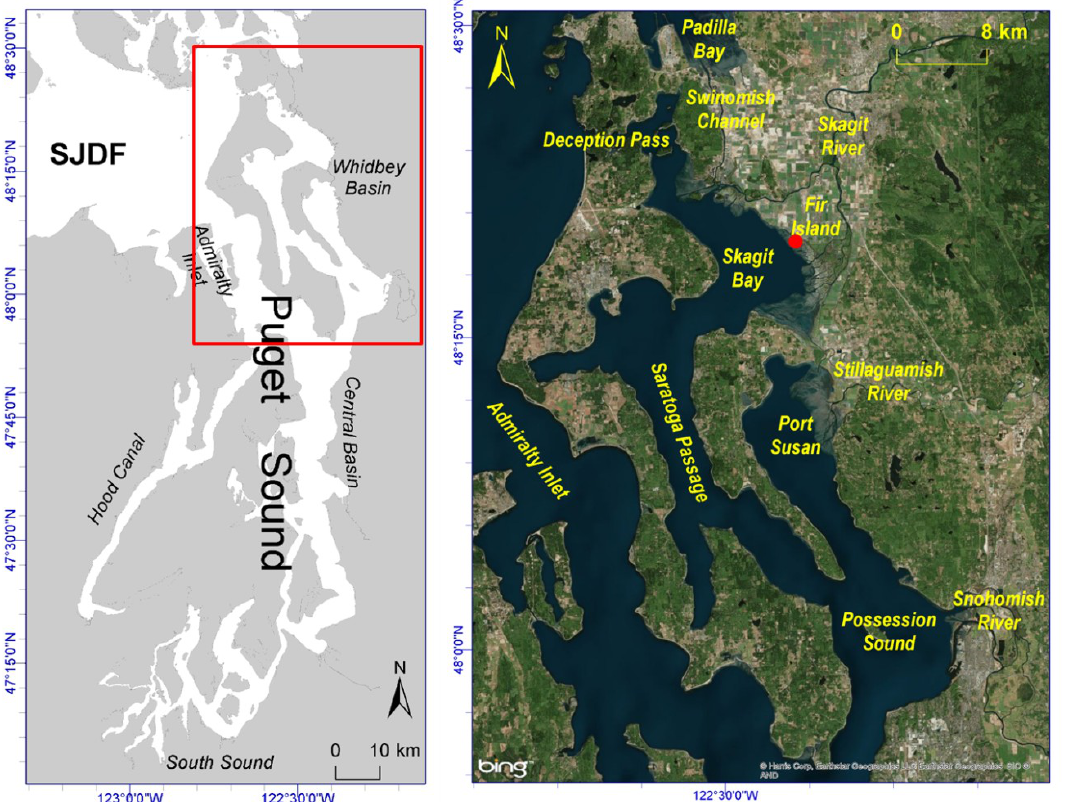
Figure 1. Puget Sound estuarine system ( left ) and Skagit River Estuary ( right ). Red circle indicates the location of the restoration project